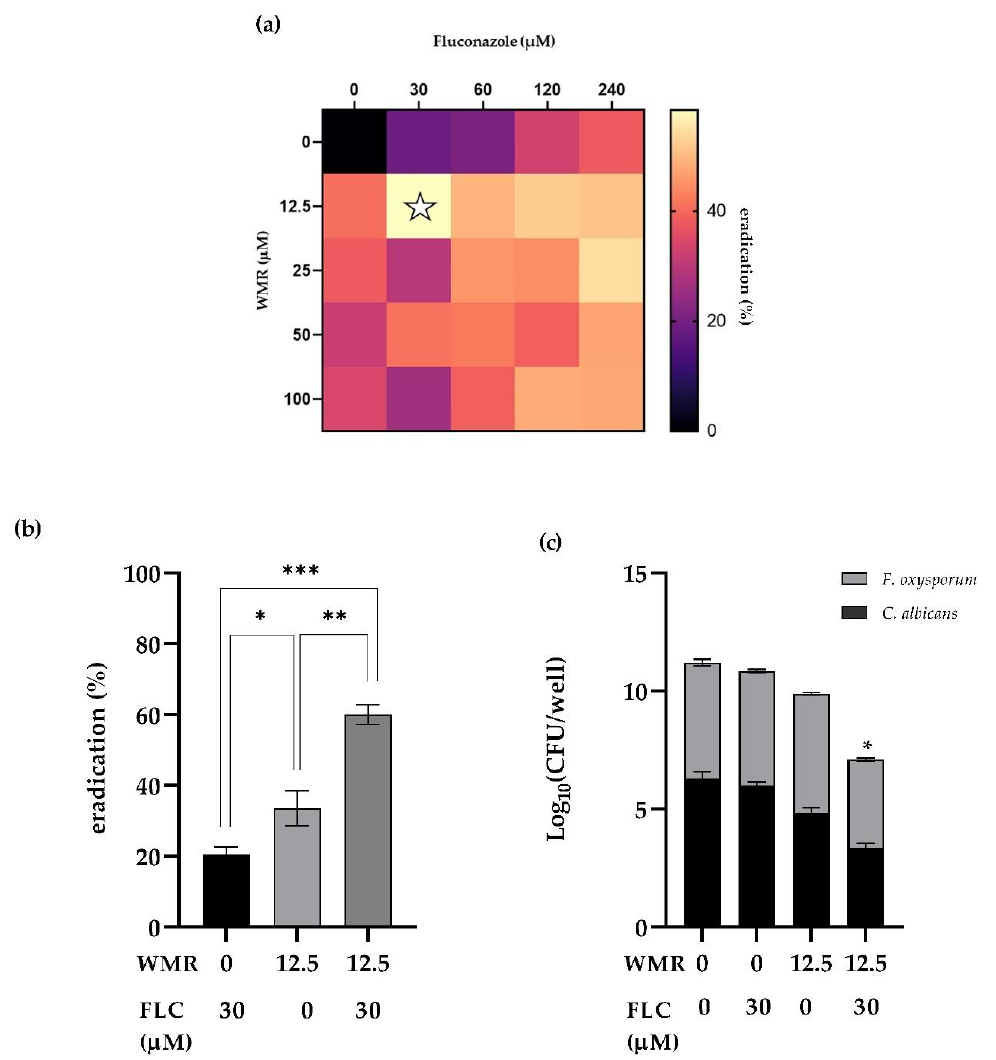
Figure 5. Assessment of antibiofilm activity of WMR and FLC against pre-formed dual-species bio- films formed by C. albicans and F. oxysporum after 24 h treatment. ( a ) Quantification of biofilm bio- mass by crystal violet staining after treatment of combinatorial agents. White star indicates the se- lected combinatorial concentrations. ( b ) Comparative analysis of individual and combinatorial effi- cacy of WMR and FLC at synergistic combination concentrations against dual-biofilm of C. albi- cans / F. oxysporum. ( c ) Bar graph representing the number of CFU by C. albicans and F. oxysporum grown in the absence and presence of identified synergistic combination. Statistical significance: * p < 0.05; ** p < 0.01; *** p < 0.001, , ns = not significant ( Tukey’s test ). Transcriptional analysis of one of the ergosterol synthesis genes, ERG11, and one of the adhesin genes, ALS3, for C. albicans were investigated by qRT-PCR, as summarized in Figure 6. The expression levels of the two genes showed a differential behavior upon treat- ment of WMR/FLC. ERG11 was moderately upregulated, whereas ALS3 was significantly downregulated. VeA and VelB belong to the genes of the velvet regulation system, influ- encing the growth and development of the hypha, and conidiation as well as relations with the secondary metabolism for F. oxysporum , respectively. As expected, both VeA and